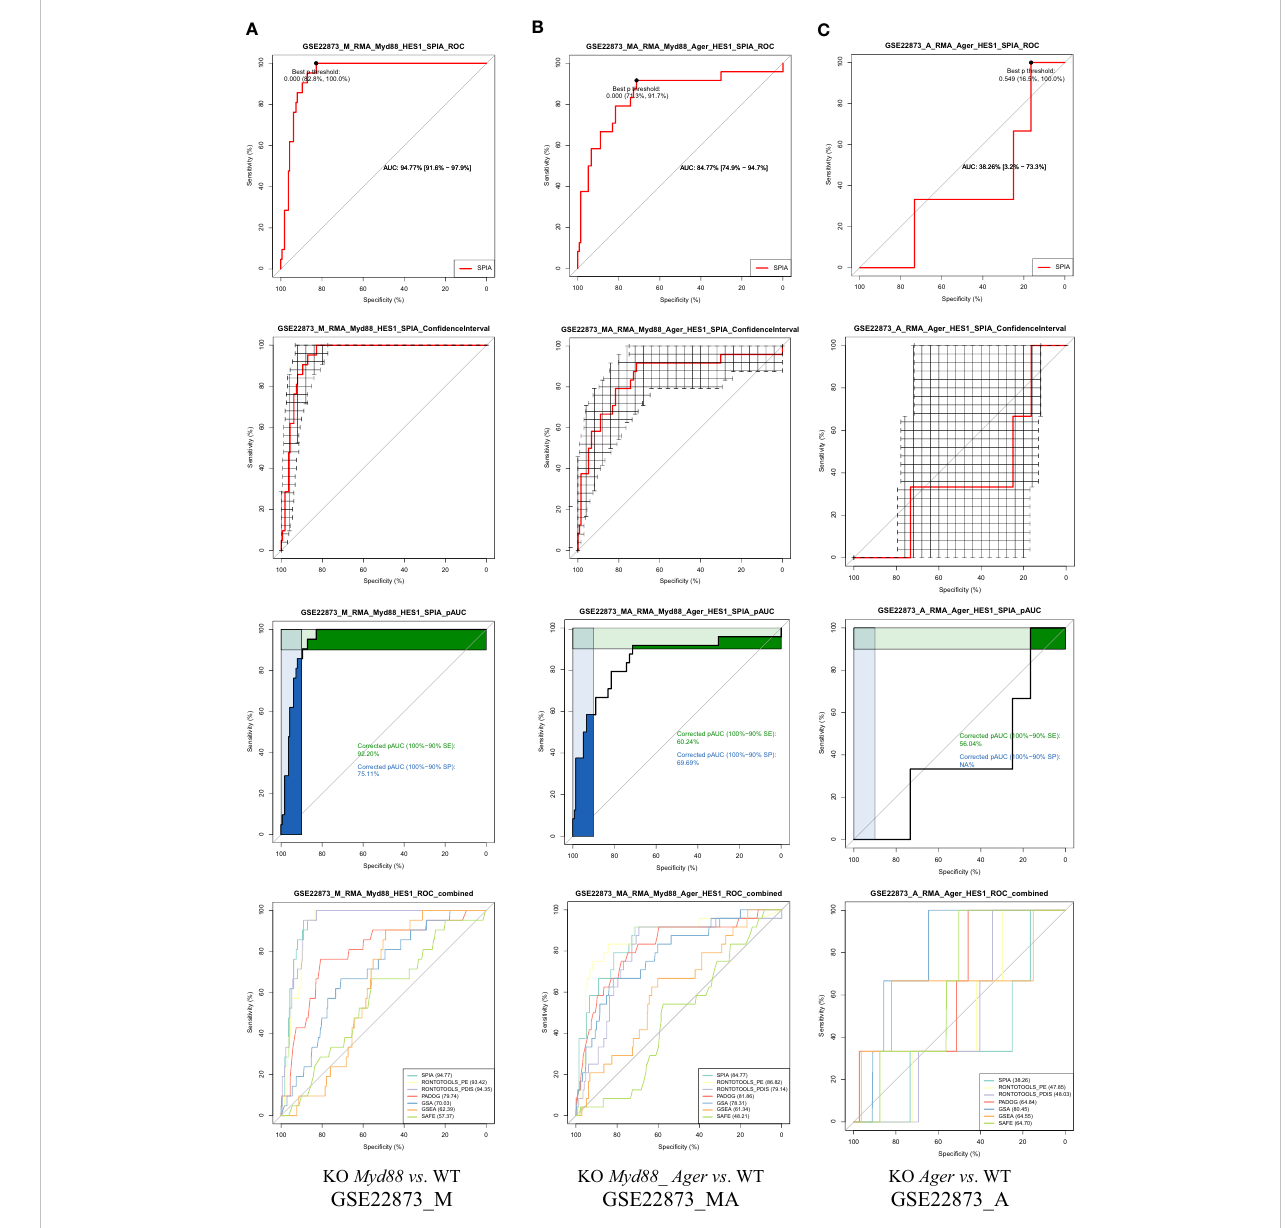
FIGURE 6 ROC curves with statistical features. GSE22873_A (KO Ager vs. WT) displays a weak signal to noise ratio, implying a lower degree of response to the stimulus. (A) GSE22873_M; (B) GSE22873_MA; (C)